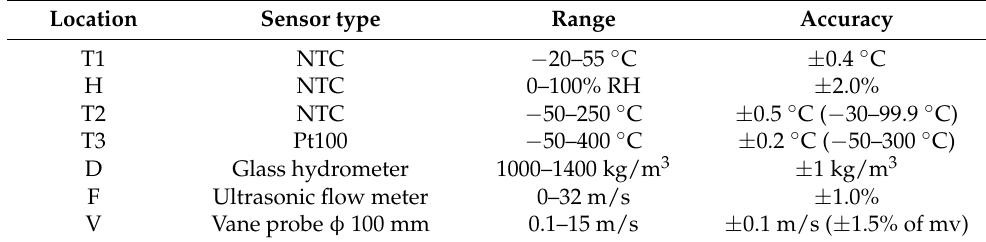
Table 2. Specifications of each sensor. RH: relative humidity.